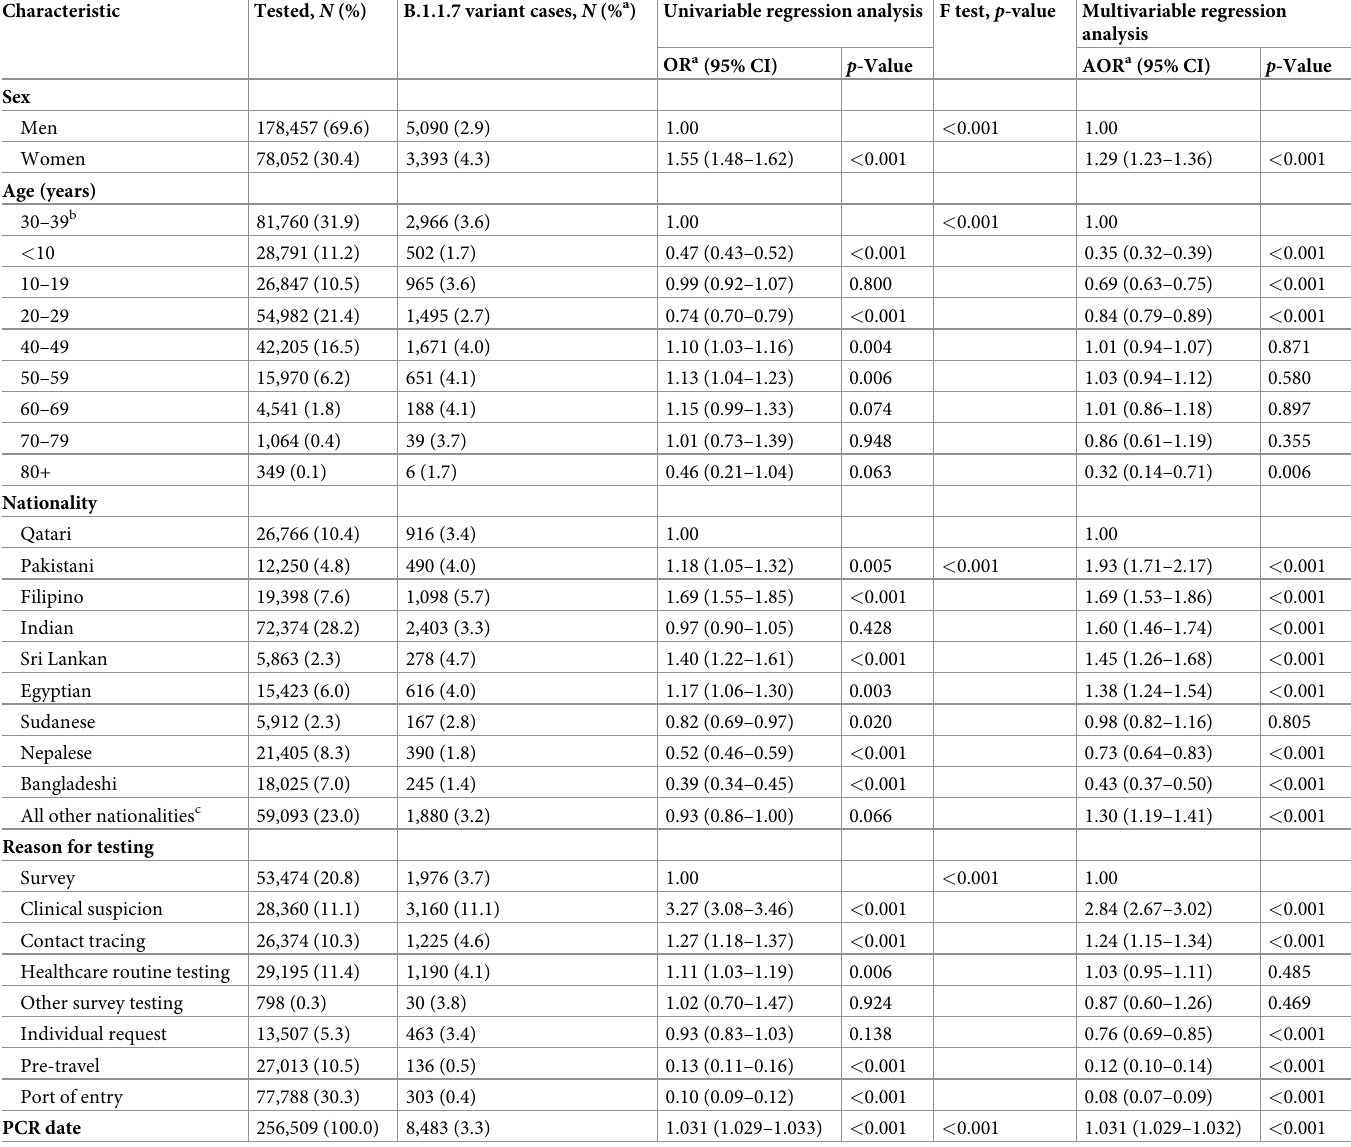
Table 1. Associations of characteristics with infection with B.1.1.7 in individuals tested for SARS-CoV-2 using PCR during the study period (18 January to 3 March 2021).